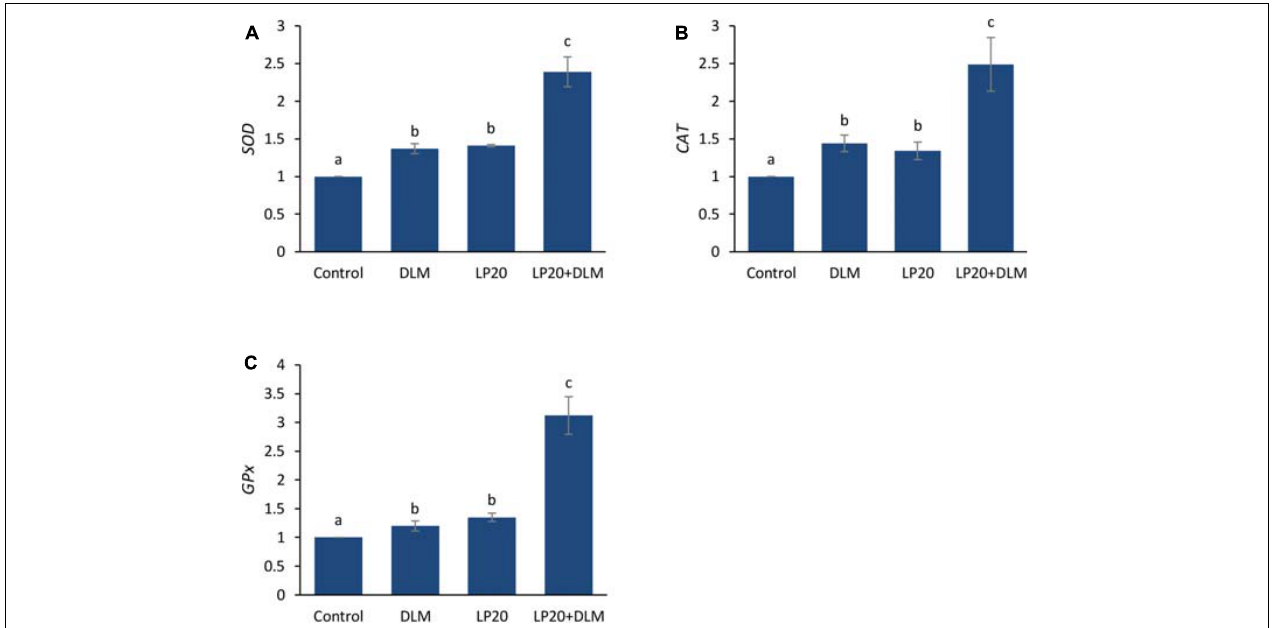
FIGURE 3 | Relative expression of antioxidative genes ( SOD , CAT , and GPx ) of Nile tilapia exposed to DLM and challenged with Aeromonas hydrophila and fed diets with or without LP20 for 30 days. Values are expressed as mean ± SE from triplicate groups (six fish per group). Bars with different letters indicate significant difference from the control group ( P < 0.05).